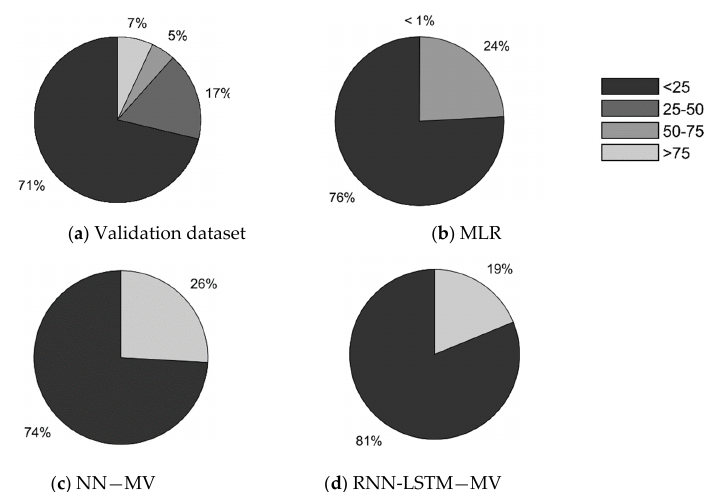
Figure 8. Pie charts comparing the percentage of measurements of a certain size within the validation dataset, where the validation dataset is depicted in ( a ) and the simulation outputs of model 6, model 8 and model 9 are depicted in ( b – d ).